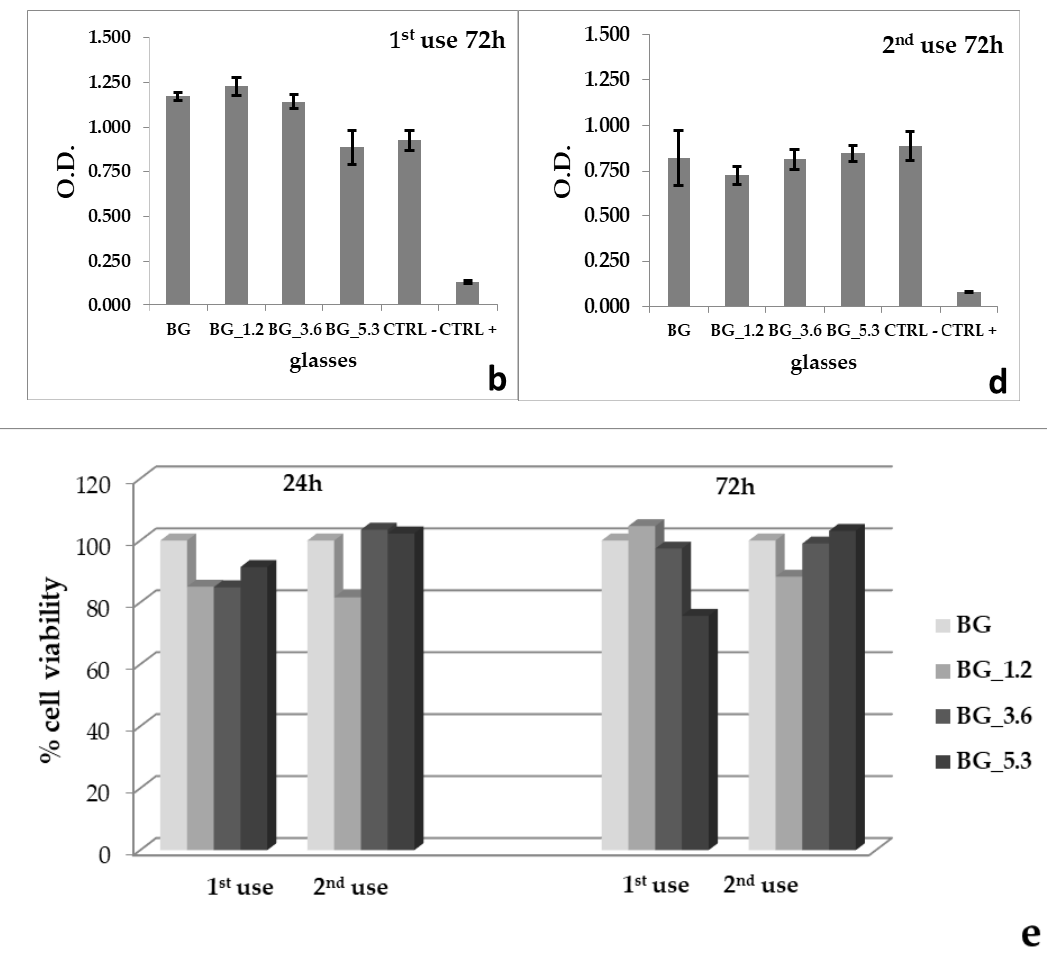
Figure 1. Neutral red (NR) uptake with osteocyte-like cell line murine long bone (MLO-Y4) cell lines after ( a , c ) 24 h, ( b , d ) 72 h for the parent glass BG and cerium-containing glasses BG_1.2, BG_3.6 and BG_5.3, together with negative (CTRL − ) and positive (CTRL + ) controls; errors bars represent standard deviation. Comparison between all doped glasses among the first and second use, after 24 and 72 h ( e ).